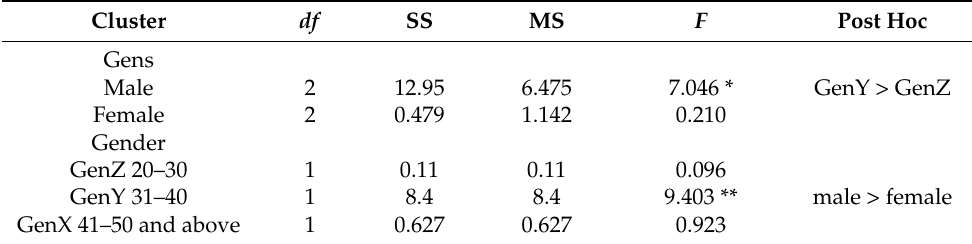
Table 8. Simple main effects of gens and gender for involvement